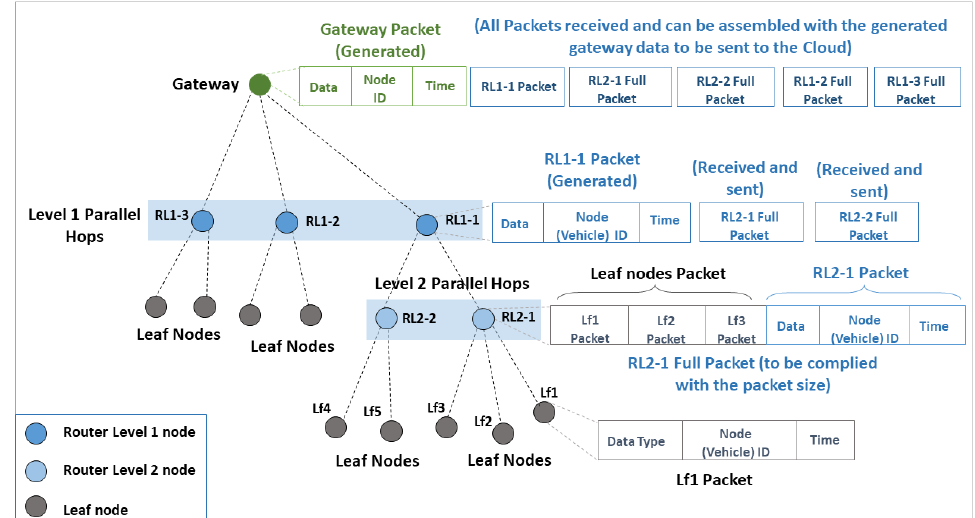
Figure 4. The packet format of a self-formulated tree structure.